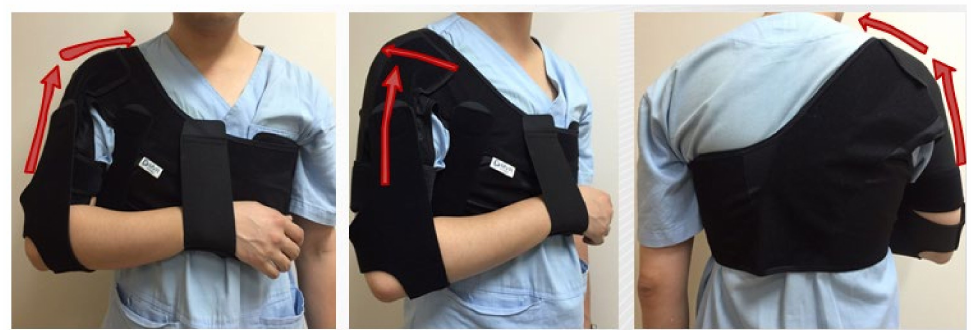
Figure 1. Elastic dynamic shoulder sling.